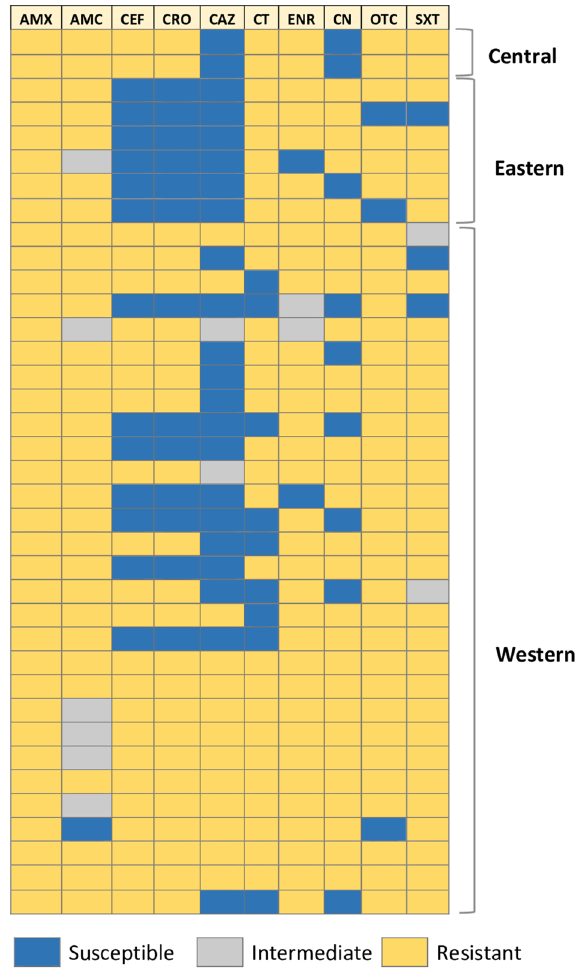
Figure 2. The MIC profiles of 37 E. coli isolates from diarrheic piglets. The right vertical axis lists the geographical regions of Thailand and the horizontal axis is labeled with the antibiotics. The color bar represents the antimicrobial susceptibility results.